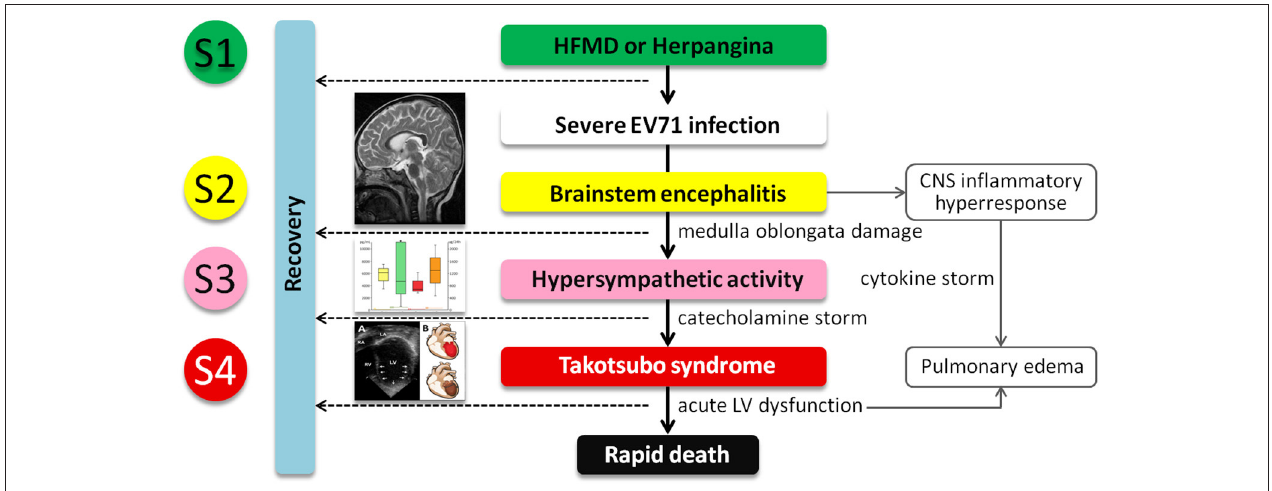
FIGURE 4 | The postulated pathogenesis of severe EV71 infection associated with catecholamine-induced secondary Takotsubo syndrome (TTS). Central nervous system indicates central nervous system; EV71, enterovirus 71; HFMD, hand-foot-and-mouth disease; LV, left ventricular; and S1–4, Stage